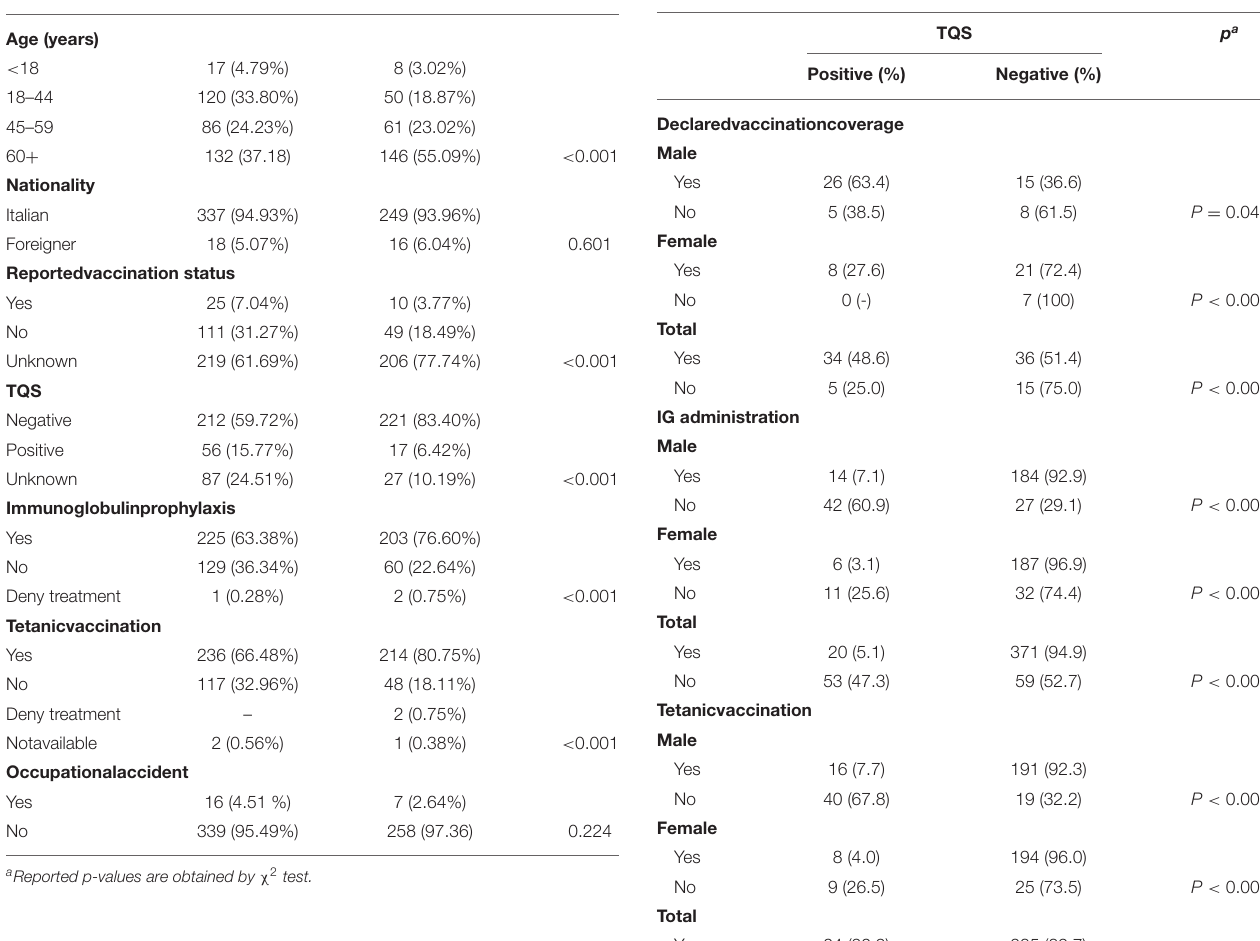
TABLE 1 | Principal features of patients included in the analysis, by sex.